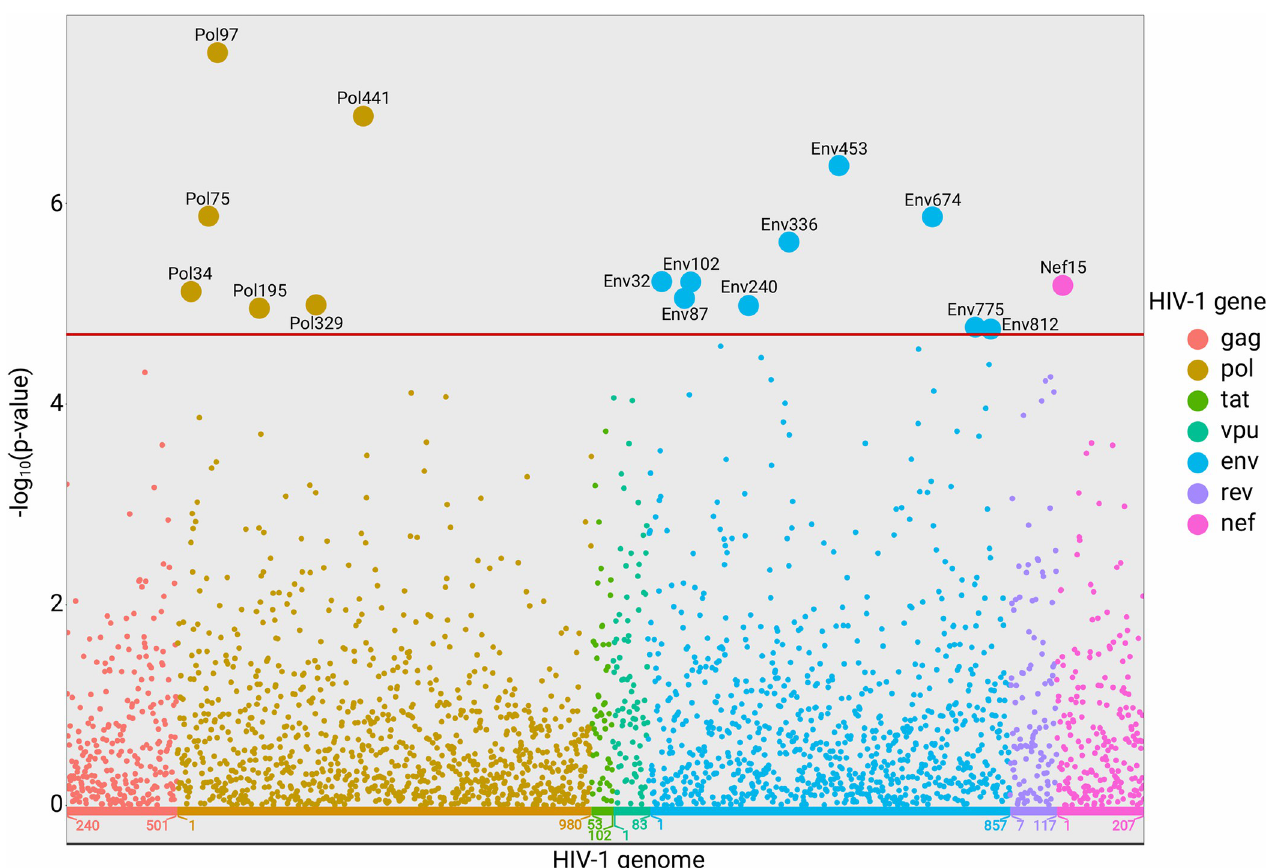
Fig 3. Manhattan plot of the associations between viral load (VL) and Shannon entropy at AA positions projected on the HIV genome. Red horizontal line marks the Bonferroni p-value threshold (p = 2.0 × 10 − 5 ). The x-axis denotes gene AA positions. A total of 2,447 HIV AA positions are shown on the x-axis. Gag positions 1–239, Pol positions 981–1004, Rev positions 1–6 and Tat positions 1–51 are not shown, as they were not covered by the amplicons.